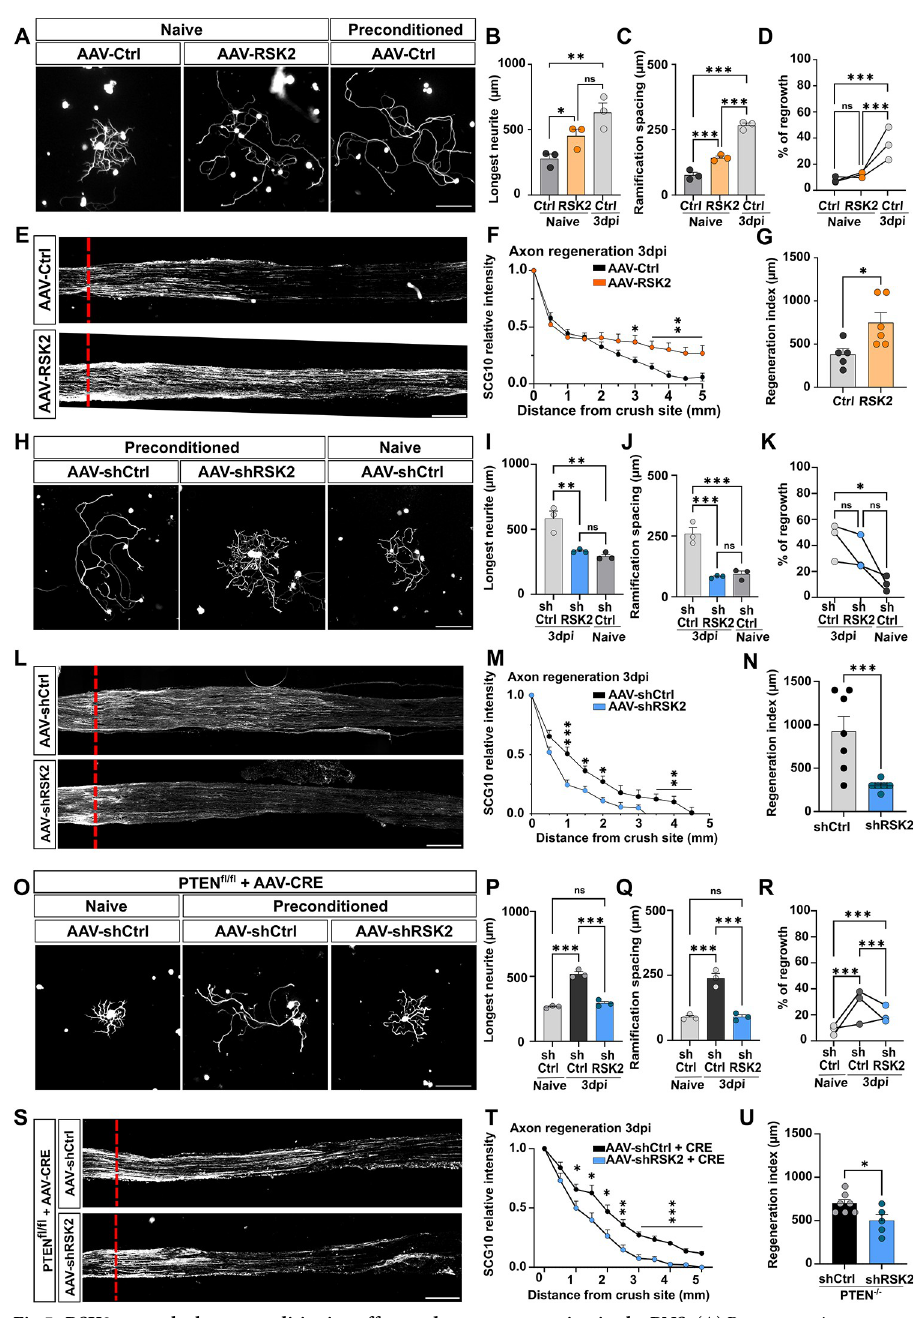
Fig 5. RSK2 controls the preconditioning effect and axon regeneration in the PNS. (A) Representative microphotographs of DRG dissociated cultures showing that RSK2 overexpression in naive cultures phenocopies the preconditioning effect. Scale bar: 250 μ m. (B–D) Quantification of A. (B) Longest neurite length per neuron 16 h after plating (mean ± SEM, Ordinary one-way ANOVA, 3 independent DRG cultures, approximately 50–100 cells counted per condition per culture). (C) Mean distance between 2 ramifications (mean ± SEM, Ordinary one-way ANOVA, 3 independent DRG cultures, approximately 50 cells counted per condition per culture) and (D) percentage of neurons growing a neurite 16 h after plating (mean ± SEM, two-way ANOVA Tukey’s multiple comparisons test, 10 random microscopy fields quantified per condition per culture). (E) Representative images of the sciatic nerve sections 3 days post-injury from mice intrathecally injected with AAV8-PLAP (control) or AAV8-RSK2. Regenerating axons are labeled with anti-SCG10 antibody (white). The red dashed line indicates the injury site. Scale bar: 500 μ m. (F) Quantification of regenerative axons from E (mean ± SEM, multiple t test, at least 6 animals per condition). (G) Regeneration index at 3 dpi (mean ± SEM, unpaired t test, at least 5 animals per condition). (H)